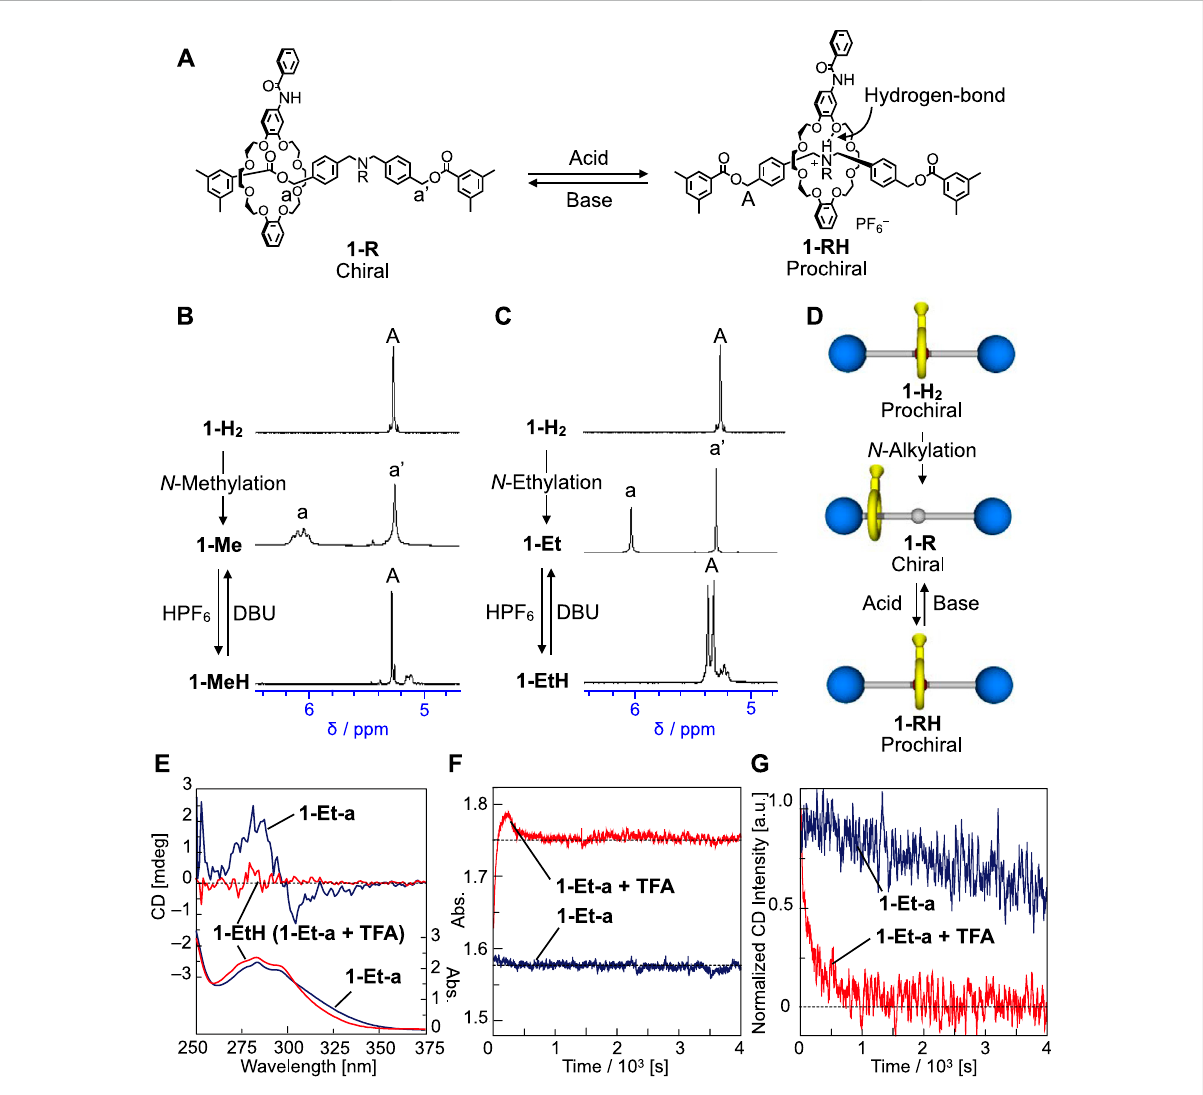
FIGURE 5 (A) Protonation and deprotonation of the nitrogen moiety of 1-R and 1-RH . Absolute structures of mechanically chiral rotaxanes could not be determined. (B) 1 H NMR spectra (400 MHz, CDCl 3 ) of 1-H 2 (298 K), 1-Me (213 K) and 1-MeH (298 K). (C) 1 H NMR spectra (400 MHz) of 1-H 2 (CDCl 3 , 298 K), 1-Et (DMSO- d 6 , 413 K) and 1-EtH (CDCl 3 , 298 K). (D) Chiralstructural changes of 1-R sand 1-RH s. (E) CD andUV spectra of 1-Et-a and